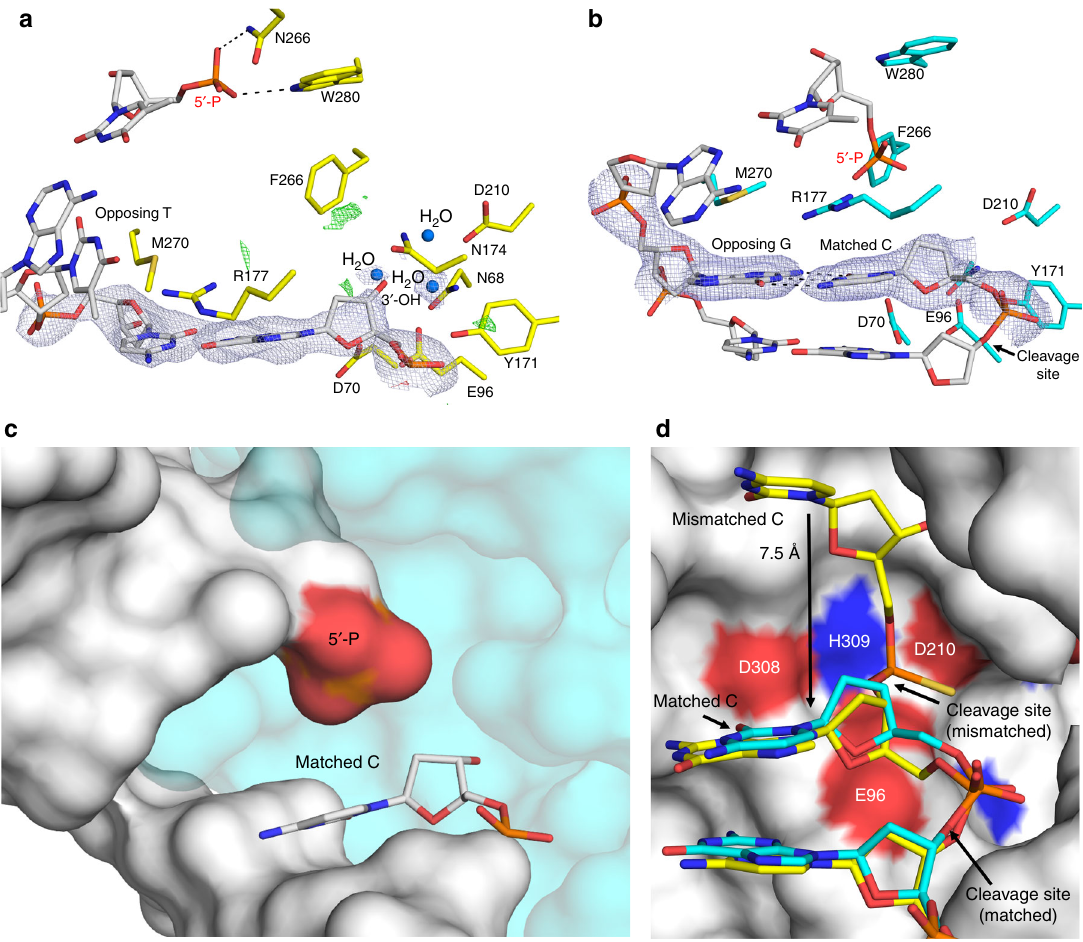
Fig. 4 Structures of APE1 bound to a 3 ʹ mismatched base exo product and a matched DNA substrate. a APE1 exo C/T mismatched product complex. 2 F o – F c map density (1 σ ) is shown in light blue. Positive (green) and negative (red) omit map densities are shown 4 Å from the 3 ′ -OH at +3 and − 3 σ , respectively. b APE1 exo C/G match substrate complex. The base pairing interaction for the C/G base pair is shown as dashes. 2 F o – F c map density (1 σ ) is shown in light blue. c APE1 exo C/G match substrate complex in surface representation. The 5 ′ -P is highlighted in red. d Overlay of the APE1 substrate complex with a C/ T mismatch and C/G match at the 3 ʹ end of a nick with DNA in yellow and cyan, respectively. Protein is from the 3 ′ mismatched structure and is shown in surface representation. The shift in location of the cleavage sites between the mismatched and matched structures is indicated by an arrow. For each structure, waters are shown as blue spheres and key residues, the site of cleavage, and distances (Å) are